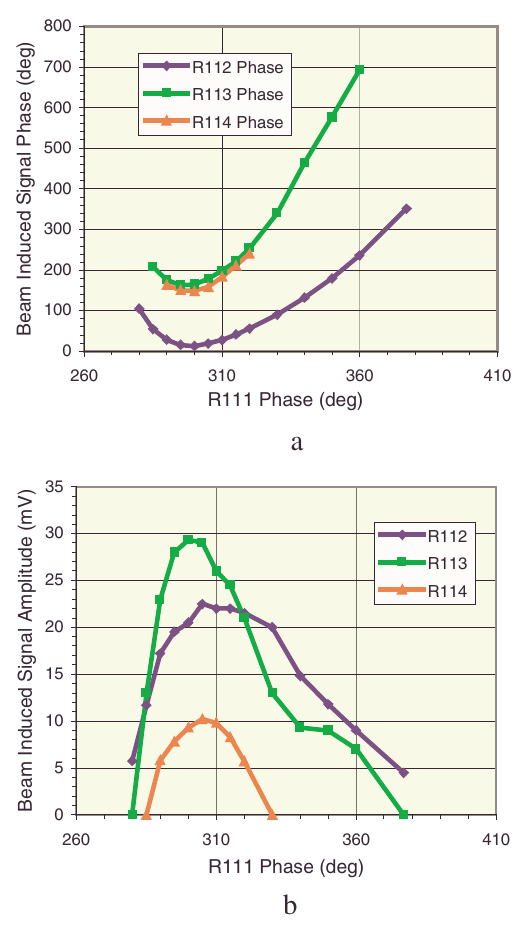
FIG. 10. (Color) Beam-induced signal phase (a) and magnitude of amplitude error modulation (b) as a function of the R 111 rf phase. Beam phase monitor was placed at three different locations, R 112 , R 113 , and R 114